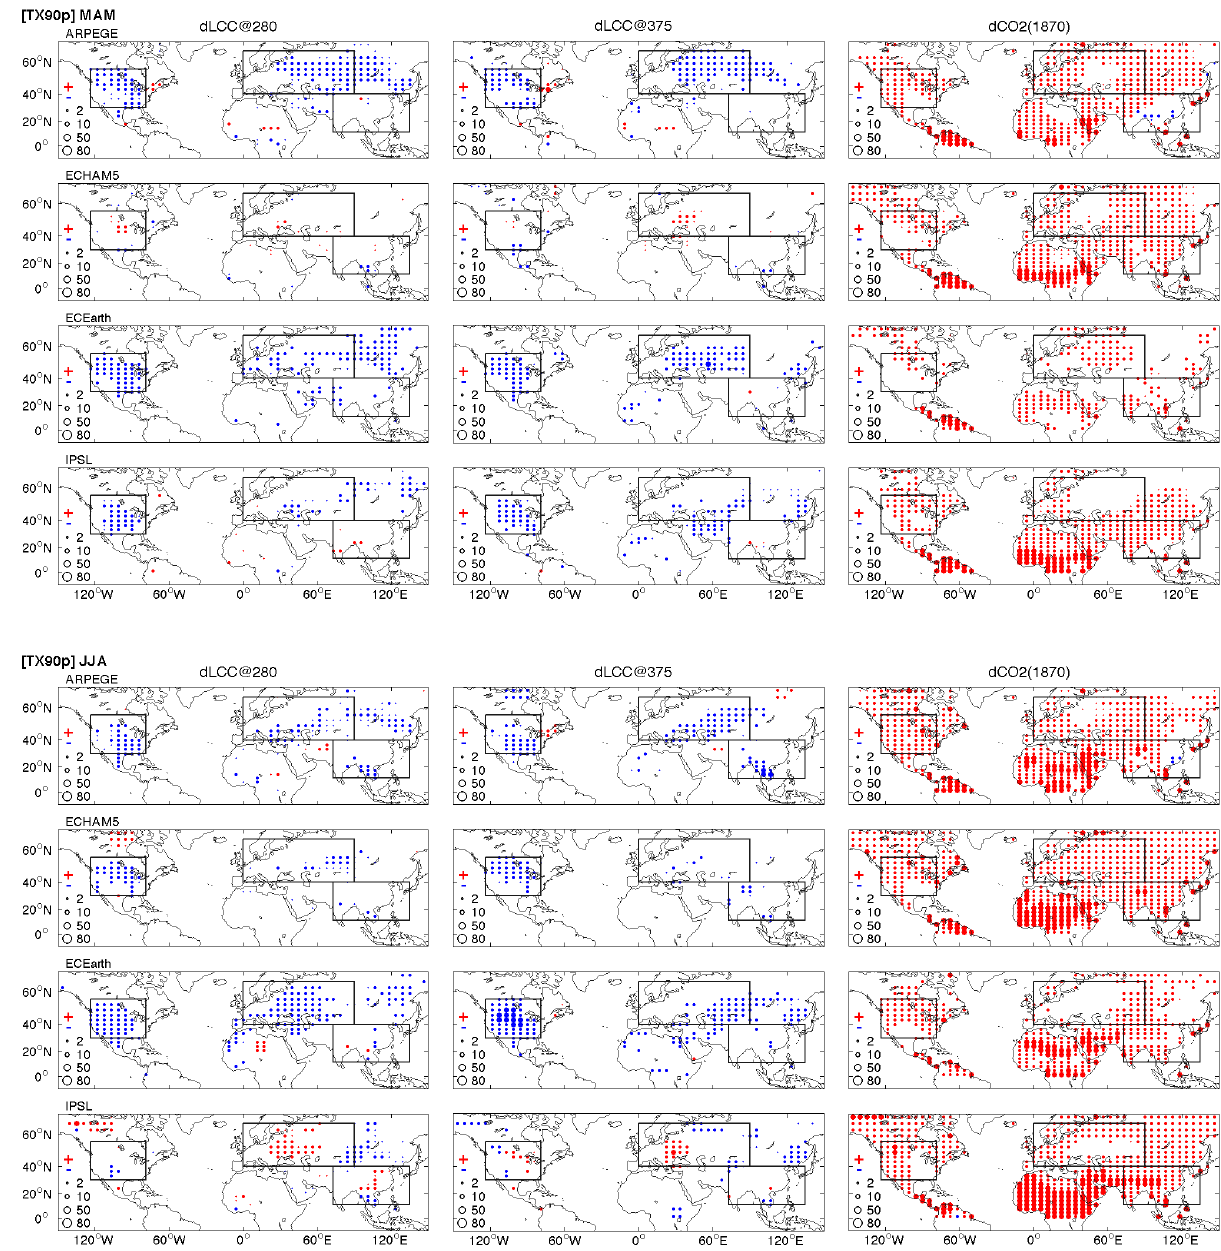
Fig. 6. As Fig. 4 but for the number of days when Tmax > 90th percentile relative to the PI simulation (TX90p, days/season).